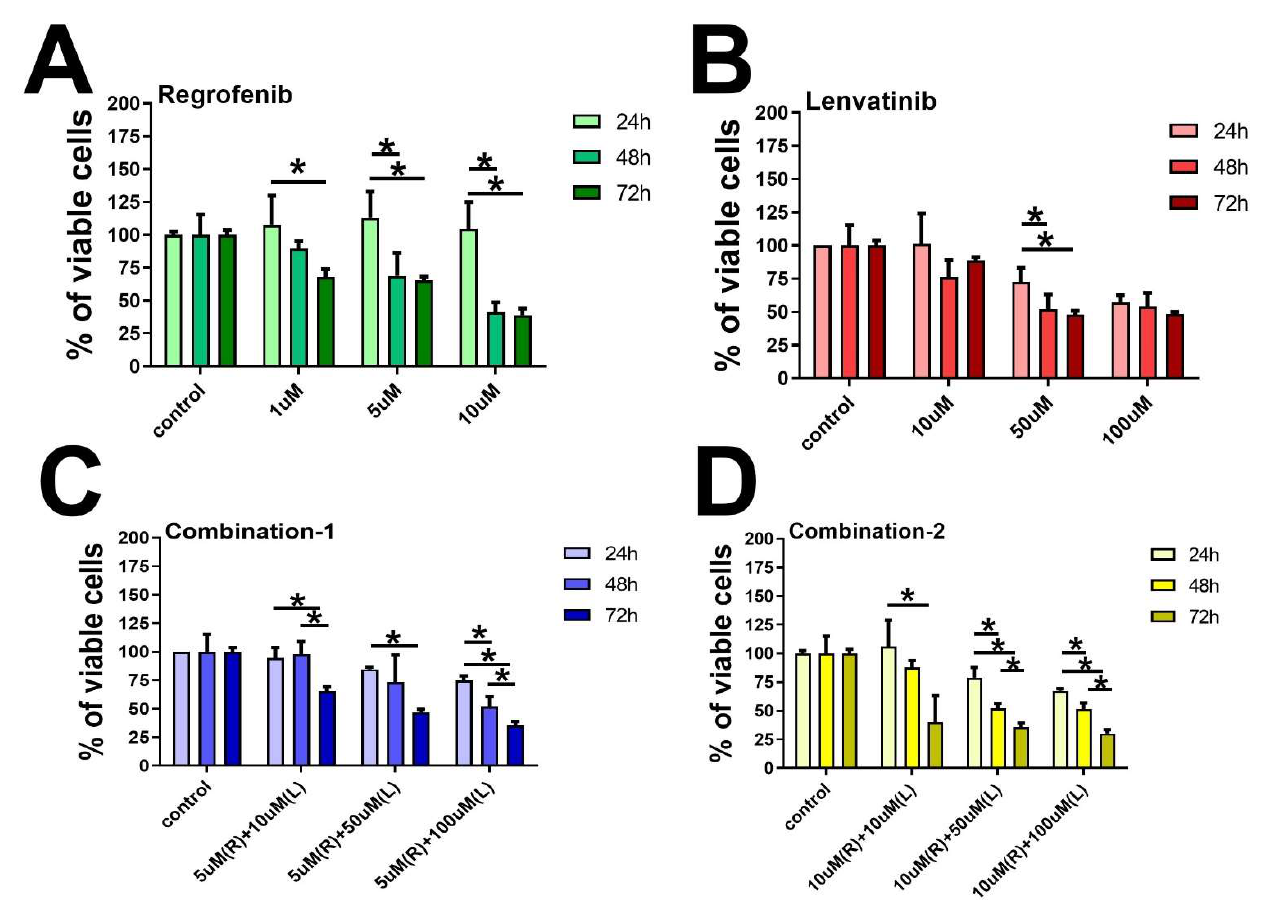
Figure 1. Effect of ( A ) Regorafenib (1, 5, and 10 µM), ( B ) Lenvatinib (10, 50, and 100 µM), ( C ) Regorafenib–Lenvatinib (Combination-1) = 5 µM Regorafenib + (10, 50, or 100) µM Lenvatinib, and ( D ) Regorafenib-Lenvatinib (Combination-2) = 10 µM Regorafenib + (10, 50, or 100) µM Lenvatinib, on cancer cell survival. MCF-7 cells were treated with various concentrations of Regorafenib, Lenvatinib, and a combination of both drugs. Dose and time-dependent survival of the cells were measured over a 24 to 72 hour period using the MTT assay. * statistically significant from the control cells, p -value < 0.05.